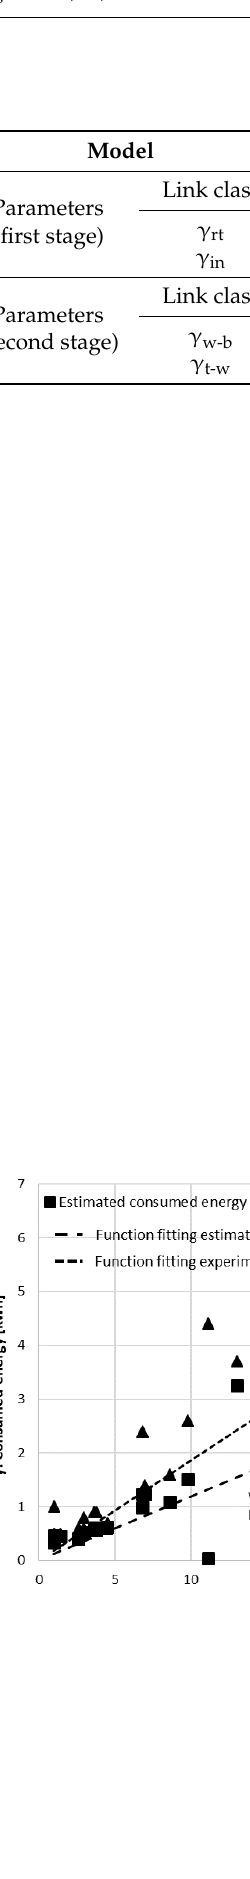
Table 5. Validation statistics. Model